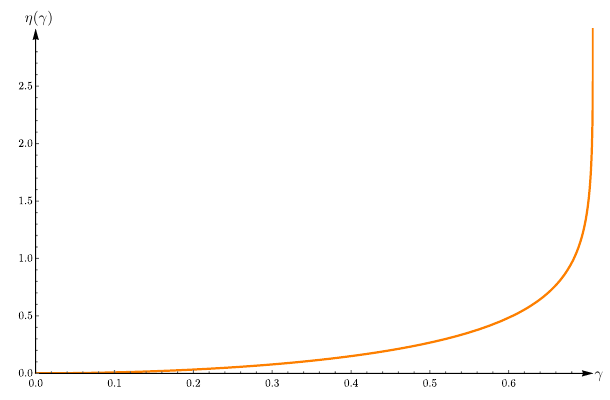
Figure 6 . Plot of η ( γ ) as defined in eq. (3.22), which is the coefficient of the log divergencies due to the